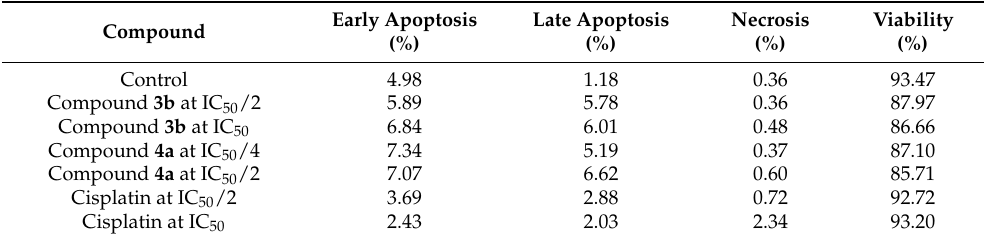
Table 5. Percentages of typical quadrant analysis of Annexin V FITC/PI flow cytometry of A549 cells treated with compounds 3b , 4a, and cisplatin.